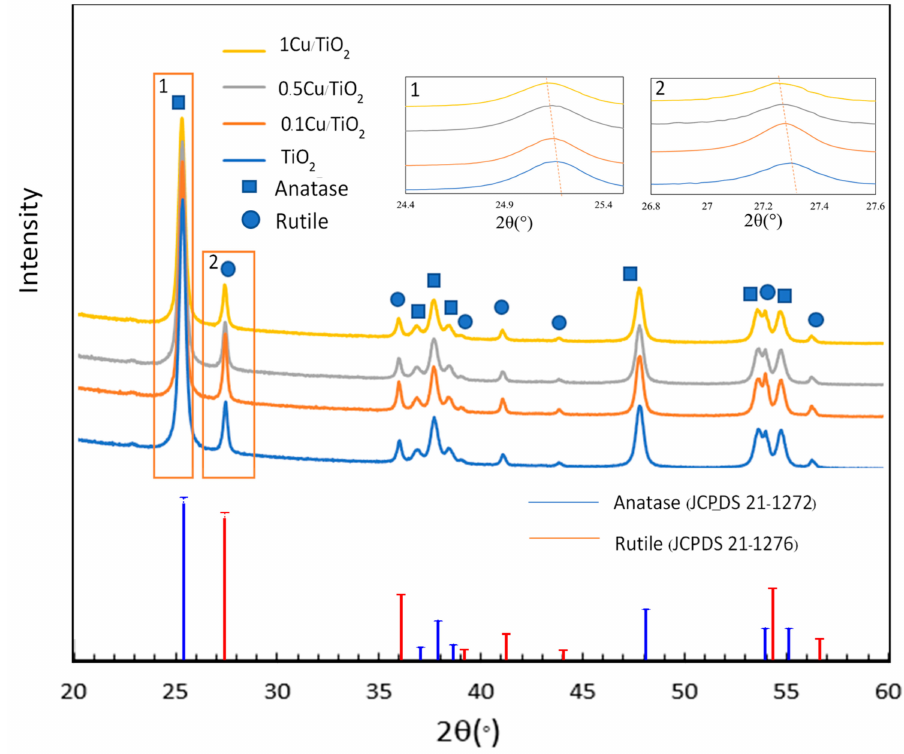
Figure 1. Patterns of Cu / TiO 2 particles at various Cu loadings.